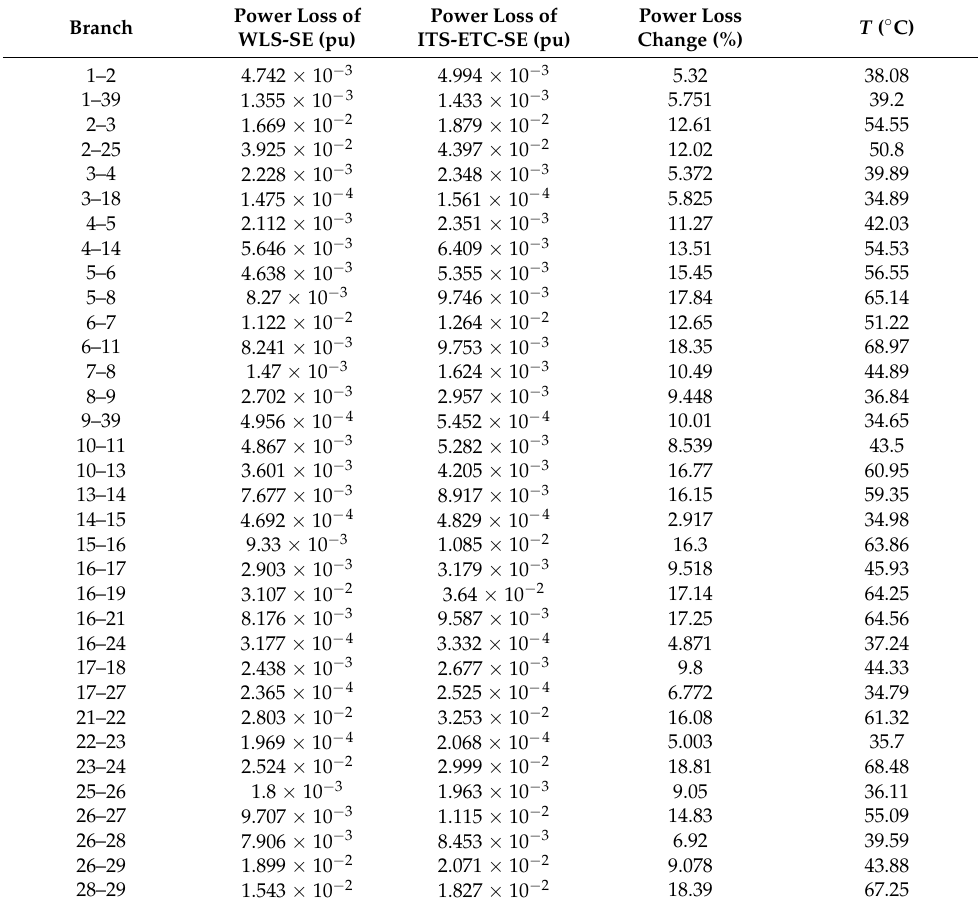
Table 3. Estimated results of the IEEE 39-bus